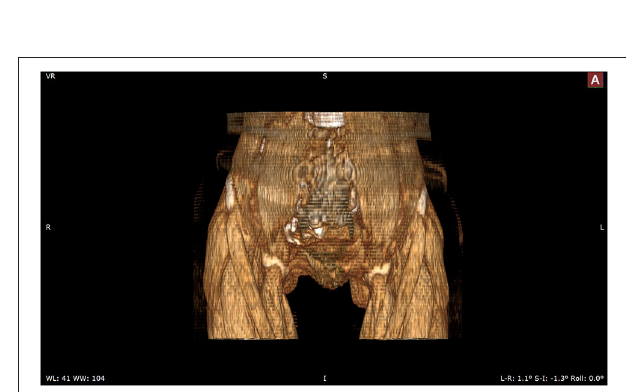
FIGURE 2 | Image showing the bicornuate uterus.